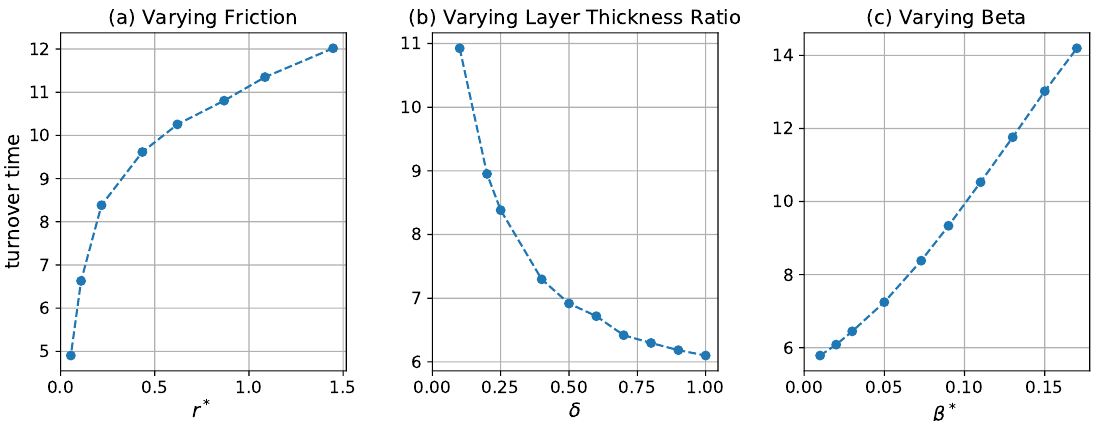
Figure 4. Eddy turnover time in days as a function of the ( a ) friction parameter, r ∗ , ( b ) layer thickness ratio, δ , and ( c ) beta parameter, β ∗